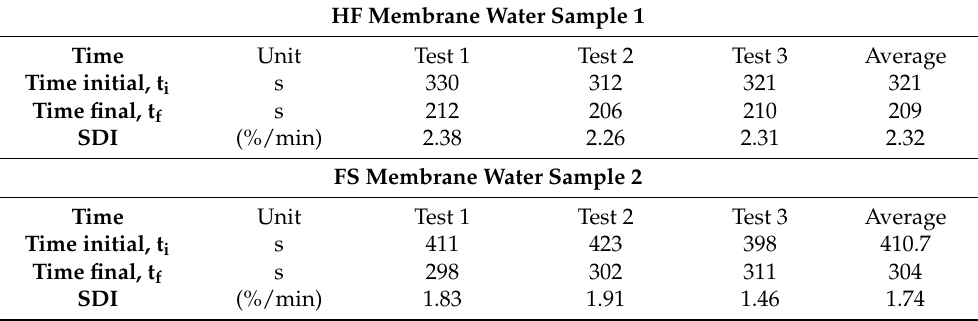
Table 7. Analysis of